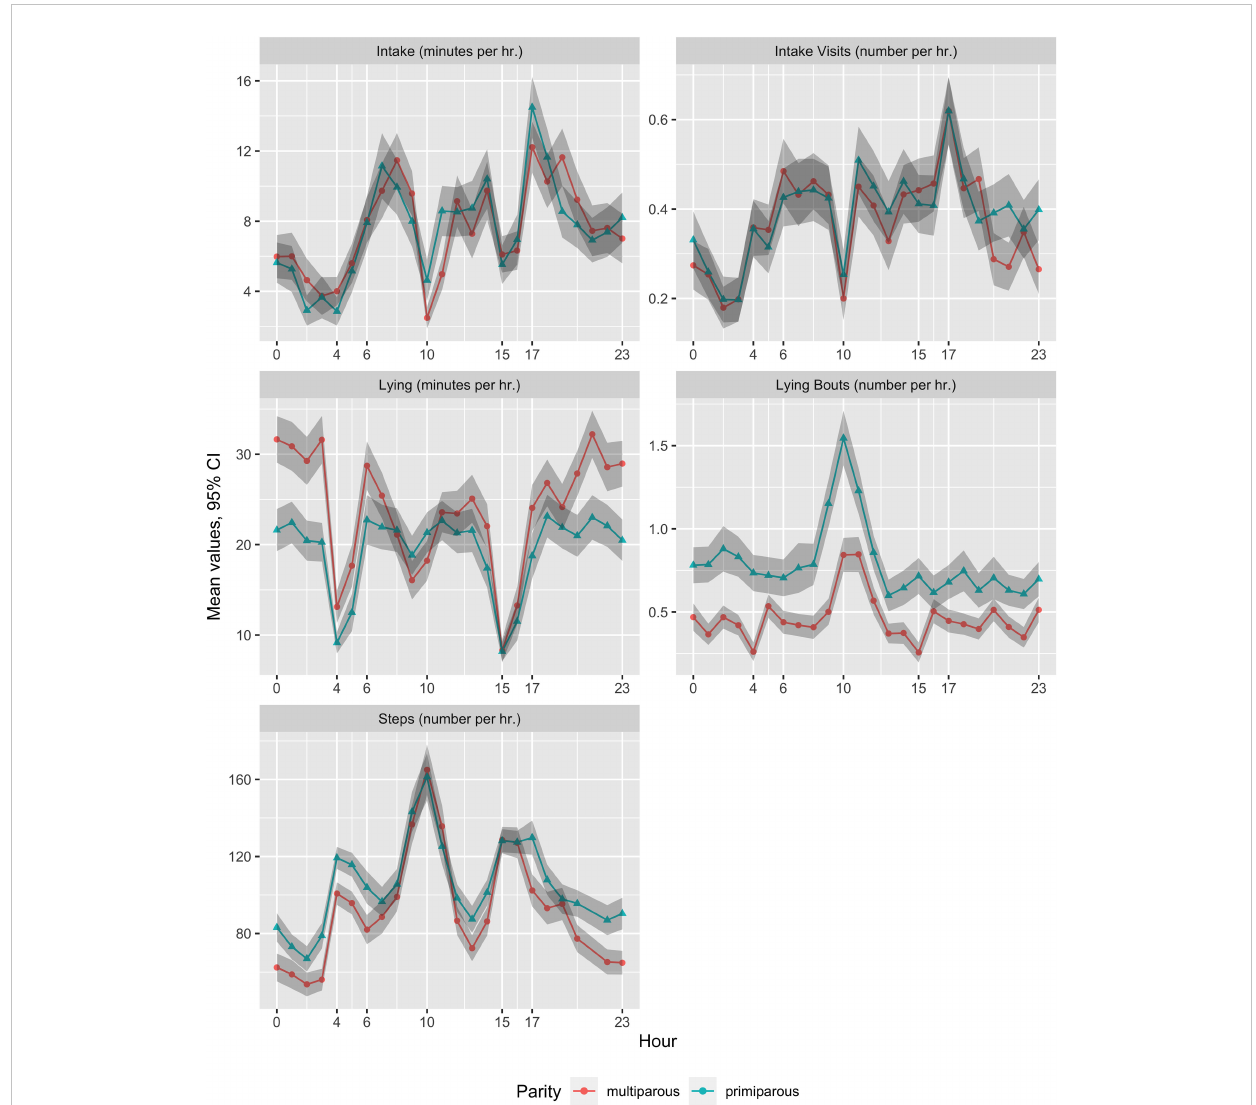
FIGURE 3 Mean raw sensor data and 95% C.I. for the mean within 24 hours for any given day of the study period strati fi ed by parity for the fi ve behavior variables measured with a leg-attached 3-axis accelerometer (TrackaCow, ENGS, Hampshire,